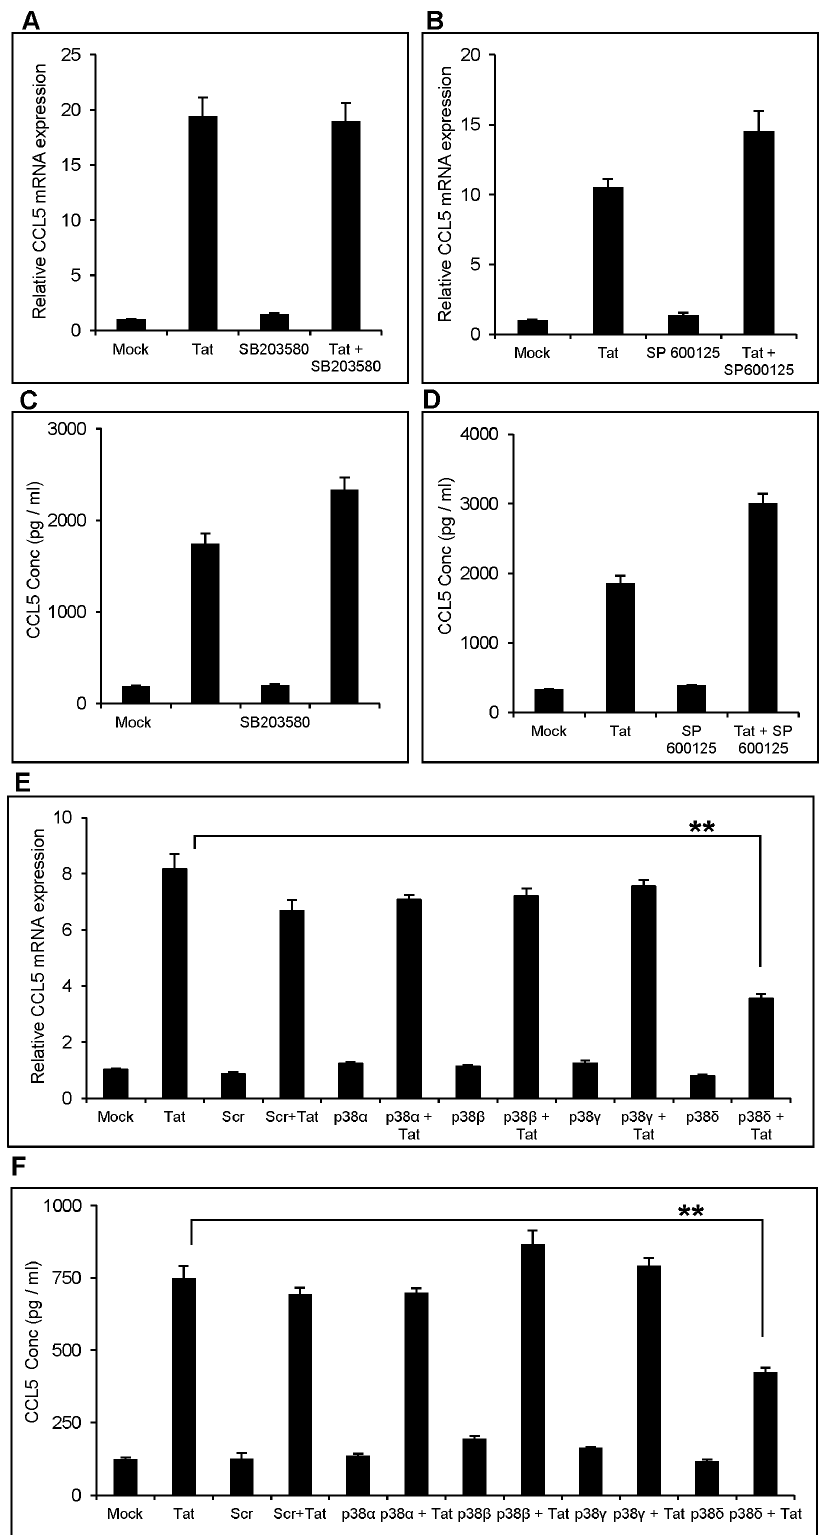
Figure 4. Inhibition of p38 MAPK reduces the induction of CCL5 by HIV-1 Tat. (A–D) SVGA astrocytes were pretreated with 10 m M of p-38 MAPK chemical inhibitor (SB203580) or JNK MAPK chemical inhibitor (SP600125) 1 h prior to the transfection with Tat plasmid. (E, F) For gene knockdown with siRNA, the cells were transfected with siRNA against p38 a , p38 b , p38 c or p38 d before transfecting with HIV-1 Tat plasmid as mentioned in the Materials and Methods. The expression of CCL5 at the mRNA and protein levels were measured at 6 h and 48 h post-transfection by using RT-PCR (A,C,E) and multiplex cytokine assay (B,D,F), respectively. The values represented for mRNA are expressed relative to the mock-